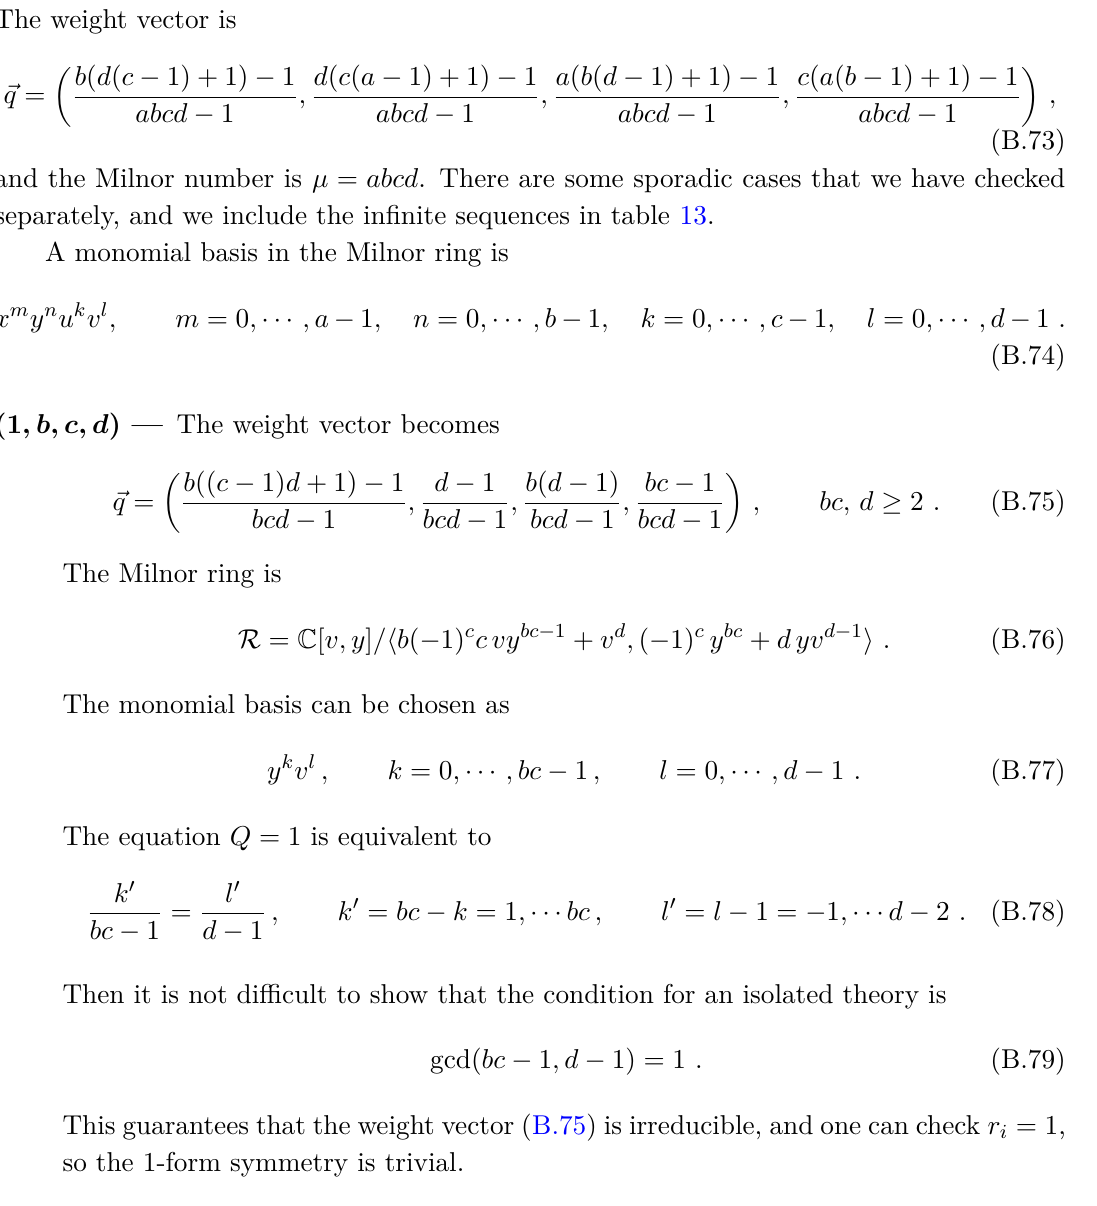
Table 13 . Infinite sequences of type XIX singularities. This table is adapted from [28].